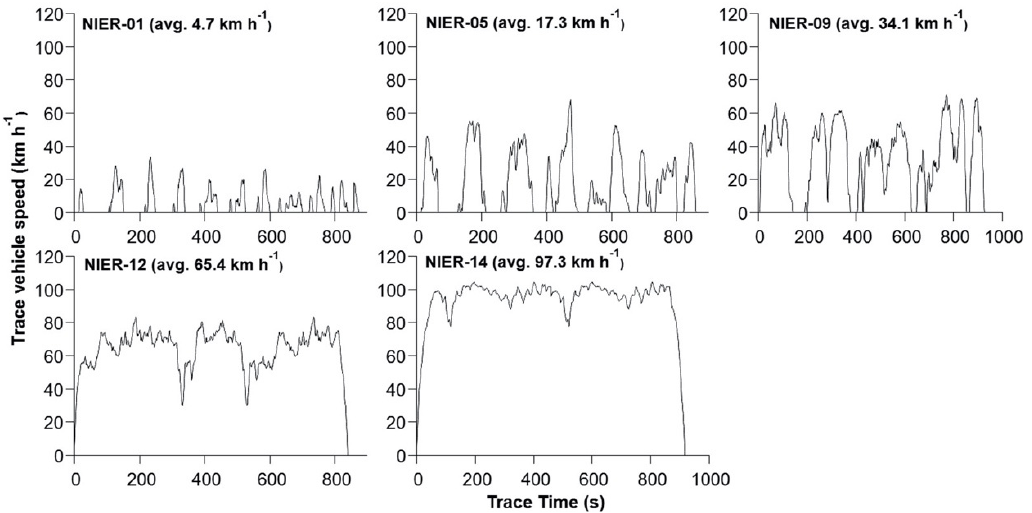
Figure 1. Five di ff erent NIER modes used in this study. Each mode represents di ff erent average speeds Figure 1. Five different NIER modes used in this study. Each mode represents different average on Korean speeds on Korean roads.